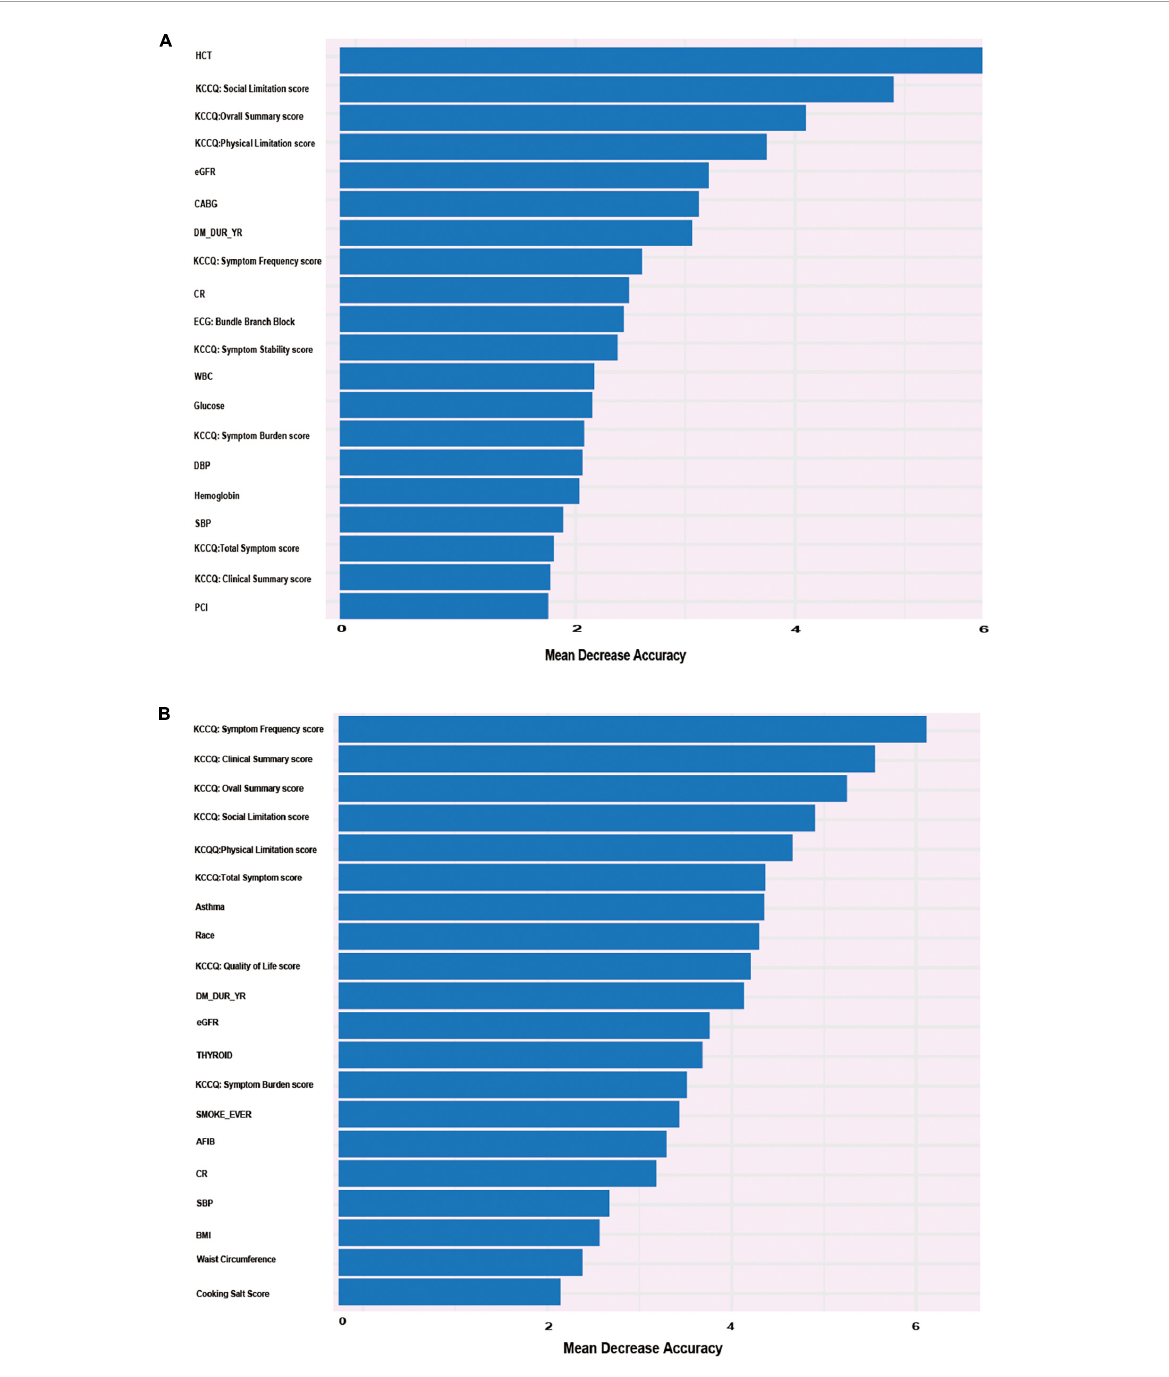
FIGURE4 Alluvial plot of the 20 most important parameters for HF re-hospitalization risk prediction identified by the VIMP metric in the RF model in the derivation cohort. (A) Twenty most important parameters for predicting the risk of re-hospitalization for heart failure at 6-year follow-up identified by VIMP method. (B) Twenty most important parameters for predicting the risk of re-hospitalization for heart failure at 1-year follow-up identified by VIMP